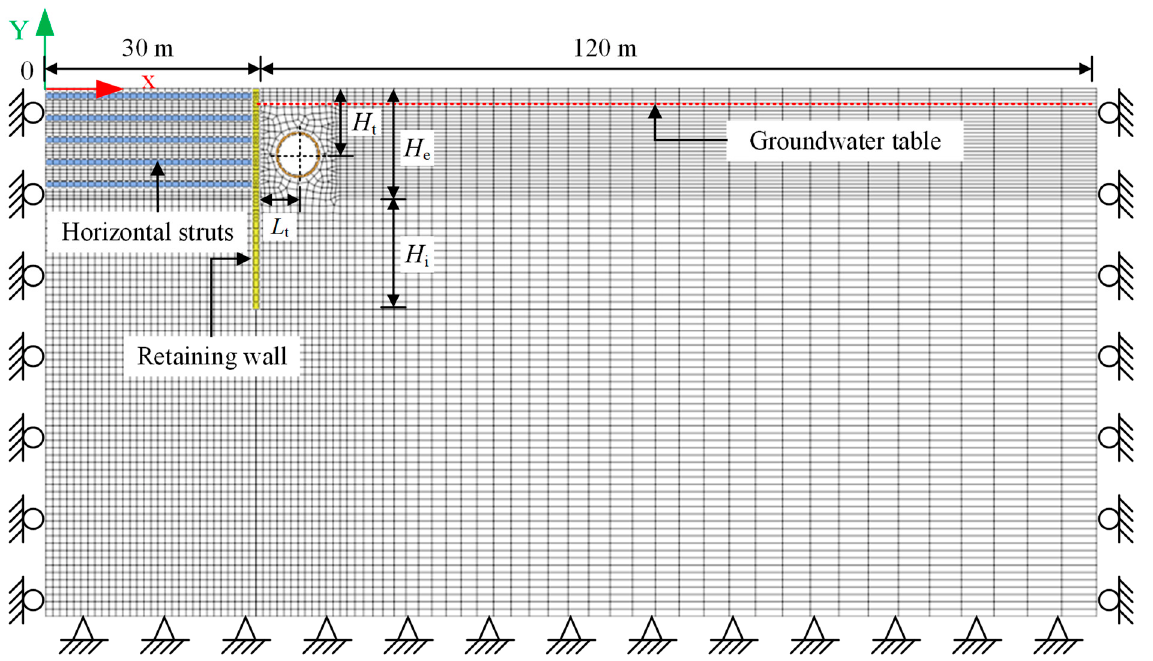
Figure 4. 2D FEM model for the e ff ect of deep excavation on the adjacent